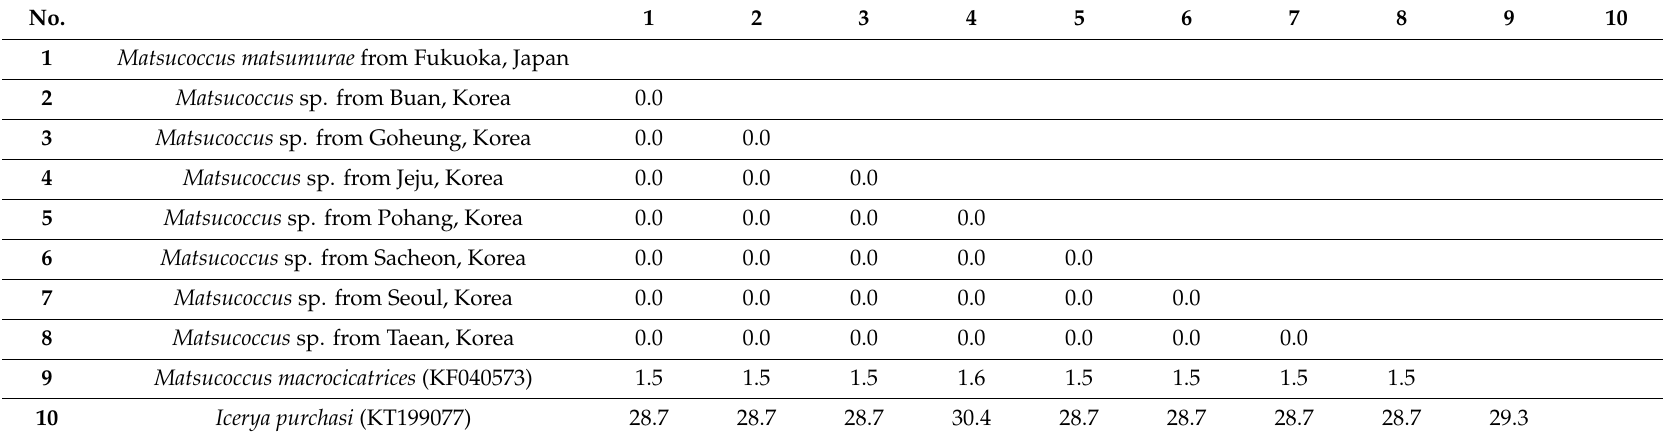
Table 4. Genetic distances (%) of 28S sequences estimated by Neighbor-Joining with Kimura-2 parameter model.